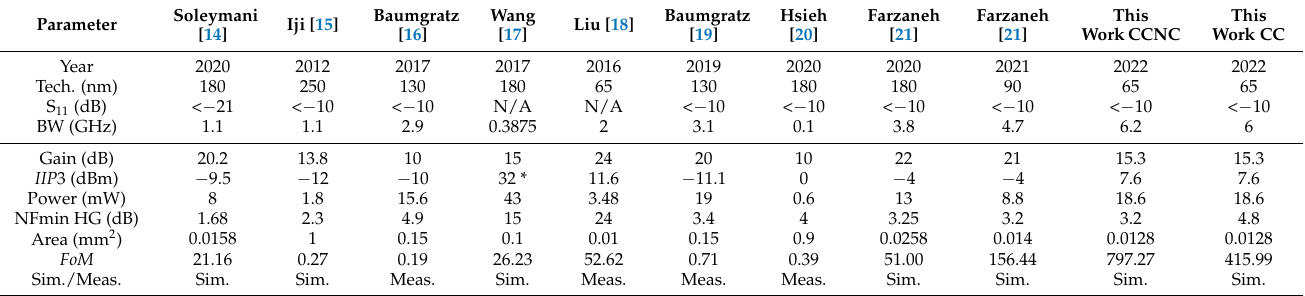
Table 2. Performance summary of the proposed LNA and similar works available in the